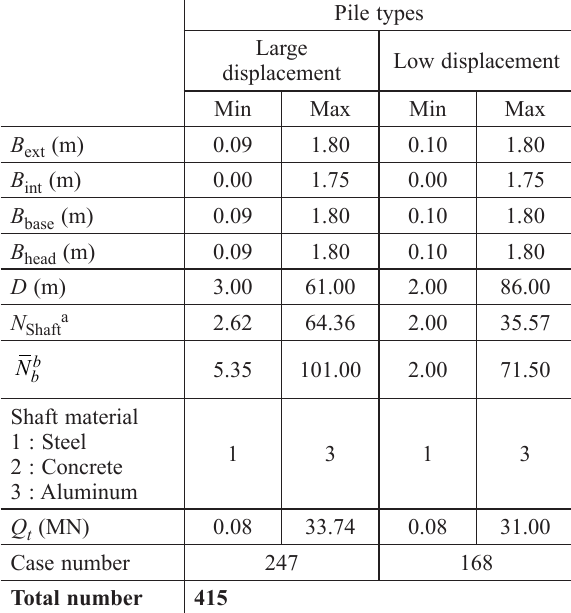
Table 4. Ranges of the database constituents